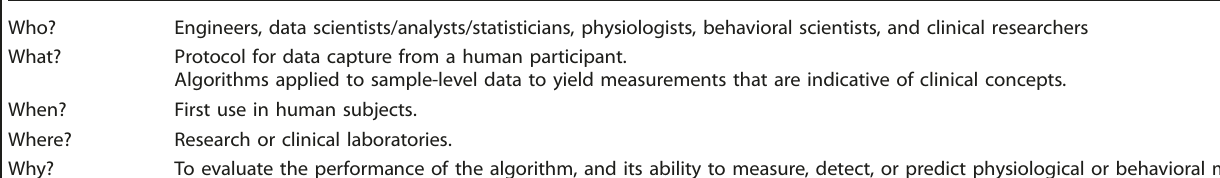
Table 4. Summary of analytical validation.